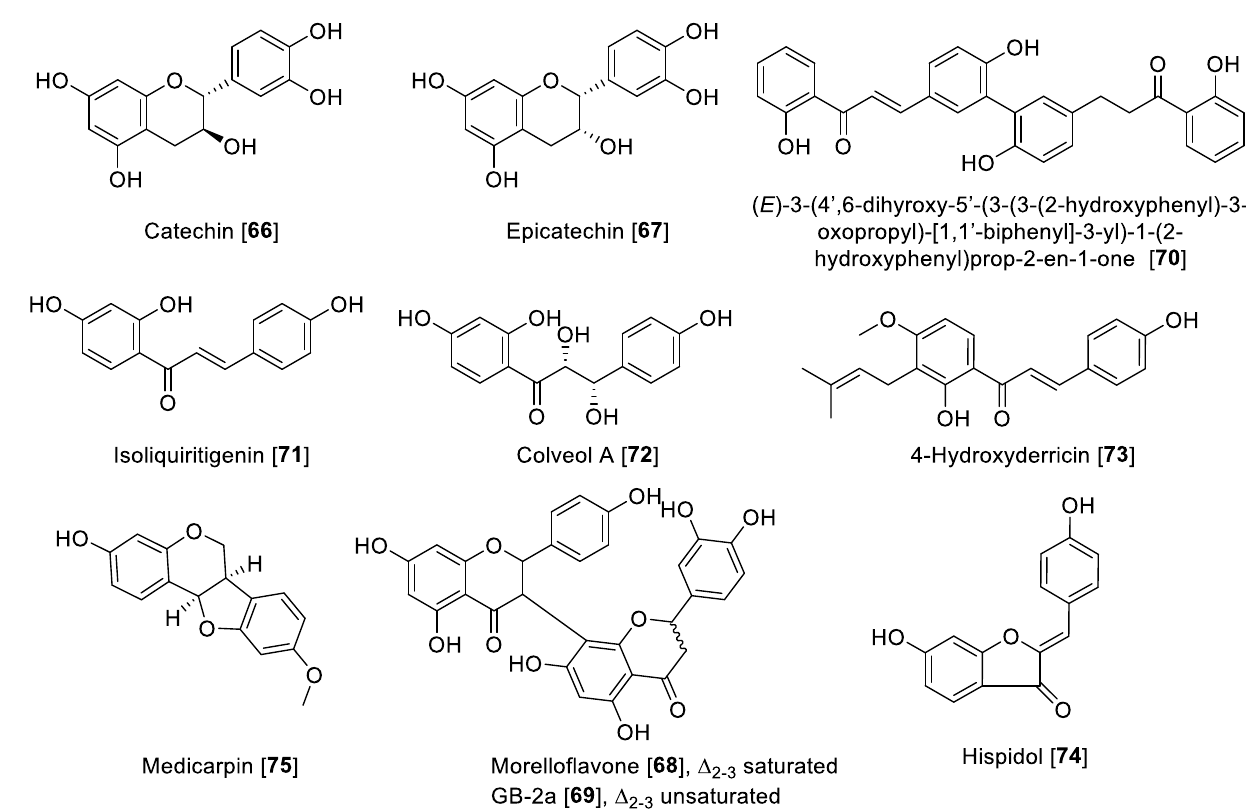
Figure 8. Chemical structure of selected miscellaneous flavonoid MAO inhibitors.